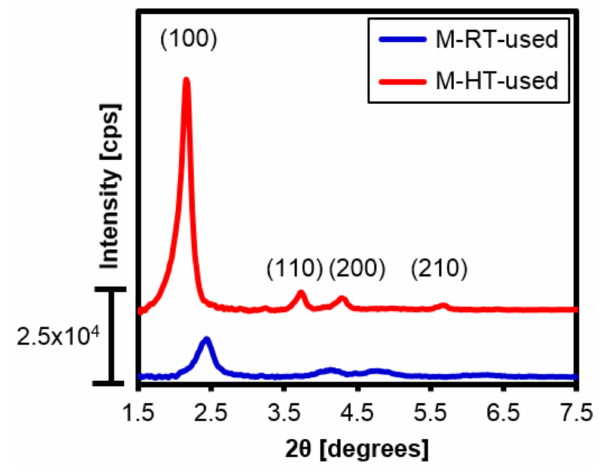
Figure 11. X-ray diffractograms of the [CTA]-MCM-41 hybrids after use in the transesterification